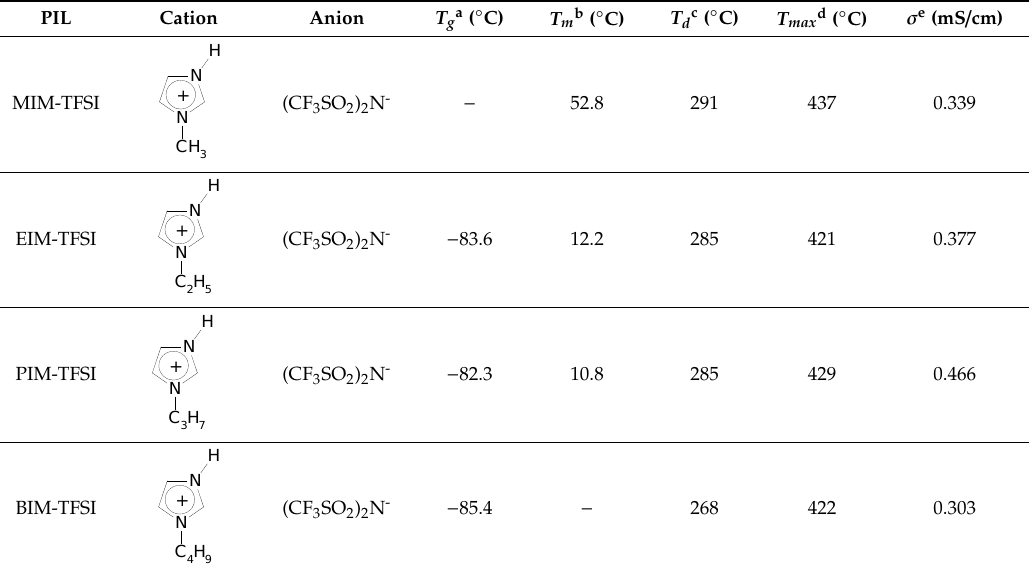
Table 1. Physico-chemical properties of synthesized protic ionic liquids (PILs).